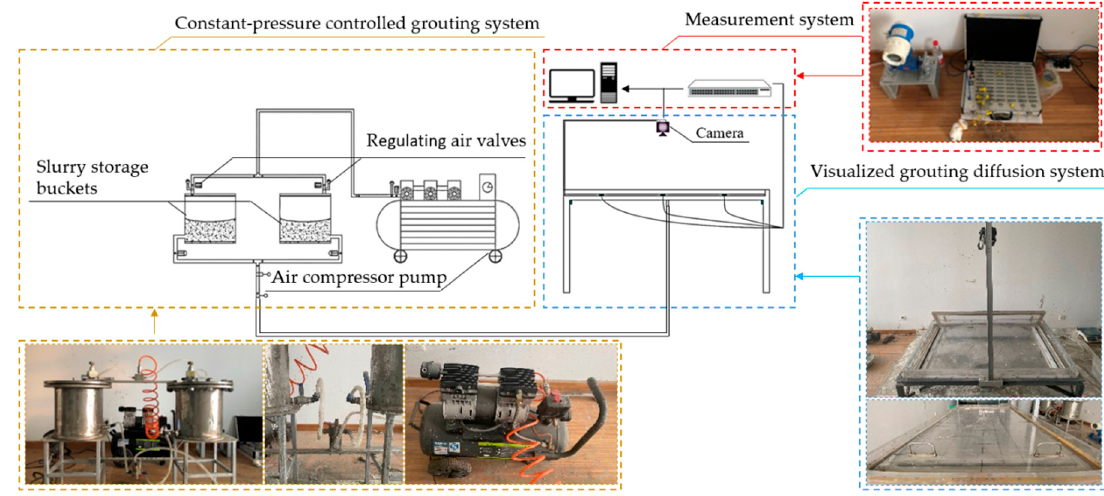
Figure 5. Overall layout of the experiment.